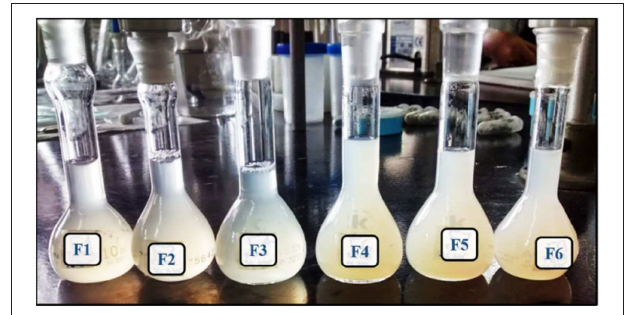
FIGURE 3 | Bioink formulations appearance at 25 ◦ C.